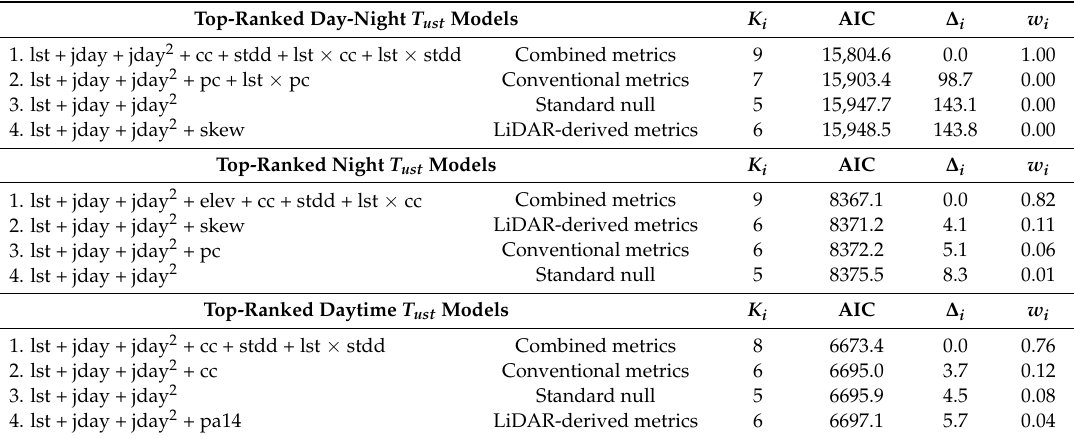
Table 4. AIC ranking of the top day-night, night, and daytime models within the candidate groupings of conventional, LiDAR-derived, and the combined metrics to predict T ust